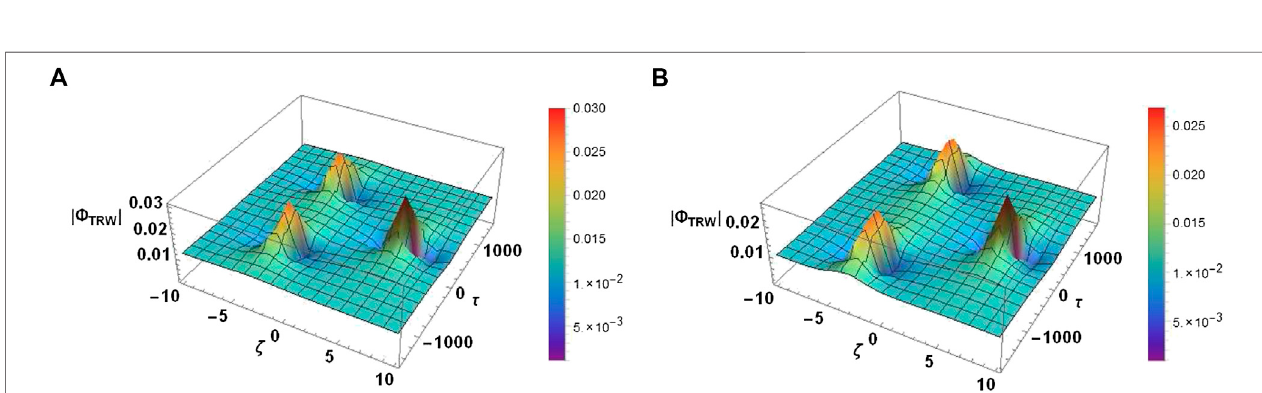
FIGURE 9 | The variation of DA-TRWs portrait in ζ - τ plane (A) for α (cid:1) 0 . 2 and (B) α (cid:1) 0 . 3, whereas R (cid:1) 0 . 11 and ρ (cid:1) 1 . 11 are fi xed.